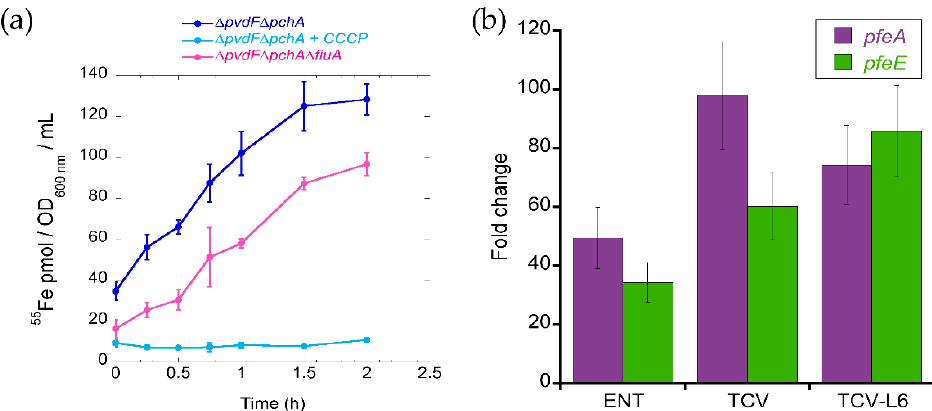
Figure 3. ( a ) 55 Fe uptake in P. aeruginosa strains using ALBO as a siderophore. ∆ pvdF ∆ pchA and its isogenic mutant ∆ pvdF ∆ pchA grown in iron-restricted casamino acid medium (CAA) medium, in the presence of 10 µ M ALBO to induce any needed OMT, were incubated with 500 nM ALBO- 55 Fe and the kinetics of 55 Fe uptake measured as previously described [23]. As a control, the experiment was repeated in the presence of 200 µ M carbonyl cyanide m -chlorophenyl hydrazine (CCCP) protonophore for ∆ pvdF ∆ pchA cells. Errors bars were calculated from three independent biological replicates. ( b ) Analysis of changes in the transcription of the pfeA and pfeE genes. RT-qPCR was performed on RNA from P. aeruginosa PAO1 cells grown in CAA medium, with or without supplementation with 10 µ M ENT, TCV, or TCVL6 conjugate. The data are normalized relative to the reference gene uvrD . The results show the ratio between the values obtained in the presence of ENT, TCV or TCVL6 over those obtained in the absence of the compounds. The data are representative of three independent experiments performed in triplicate ( n = 3). pfeA encodes the OMT of ENT and pfeE the esterase involved in ENT hydrolysis.